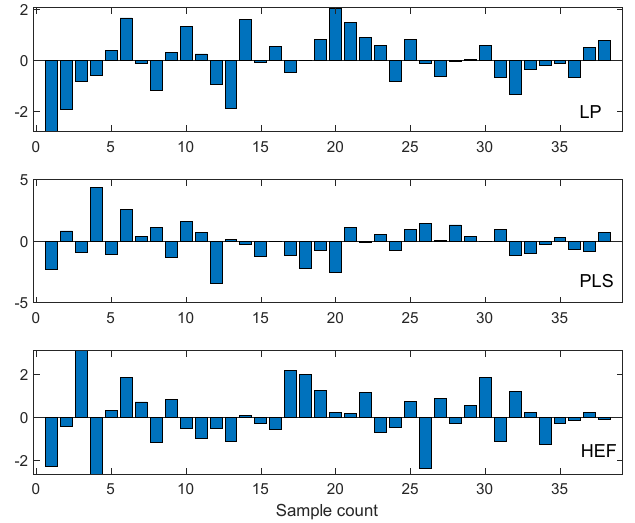
Figure 15. Relative error (in percentage) for each type of implant.